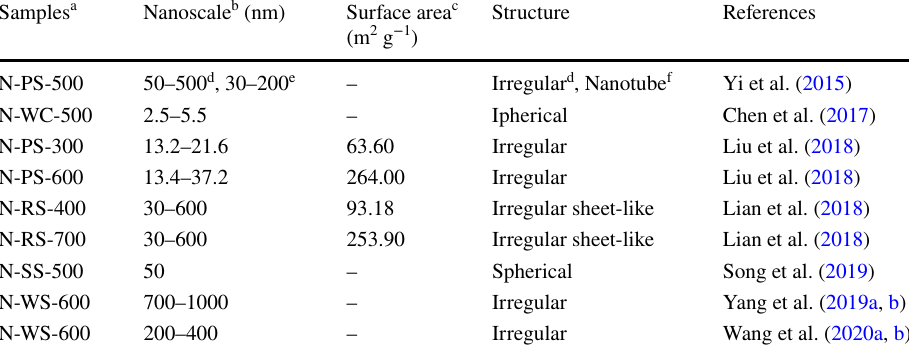
characterization of bulk biochar and biochar nanoparticles